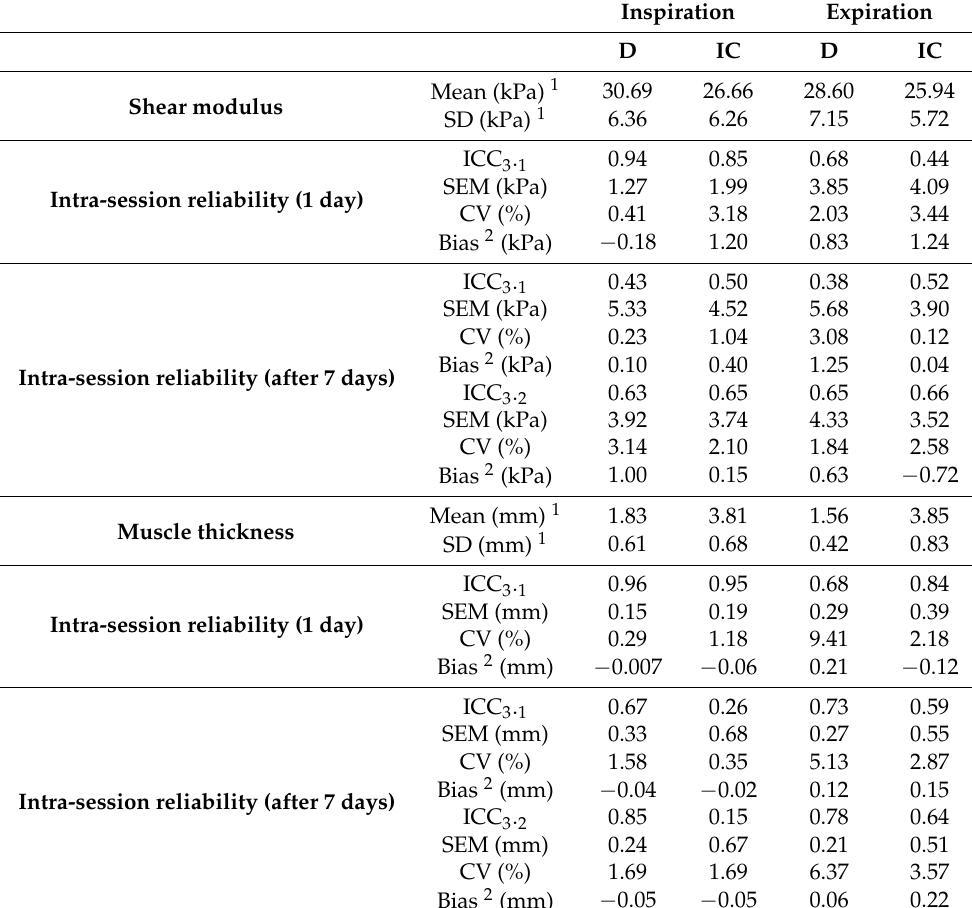
Table 2. Reliability and validity of stiffness and thickness values measured in diaphragm (D) and intercostal (IC) muscles in longitudinal probe